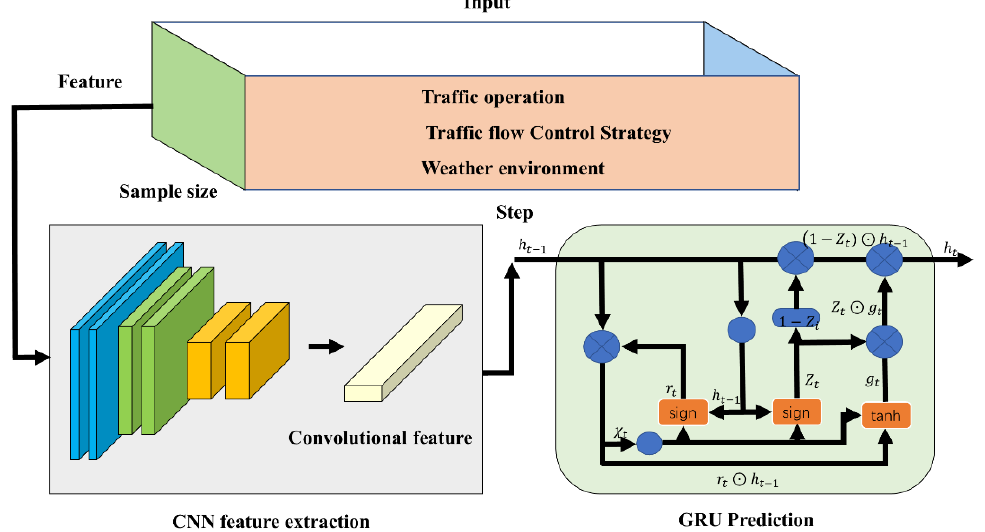
Figure 3. TSPM-W model network structure.